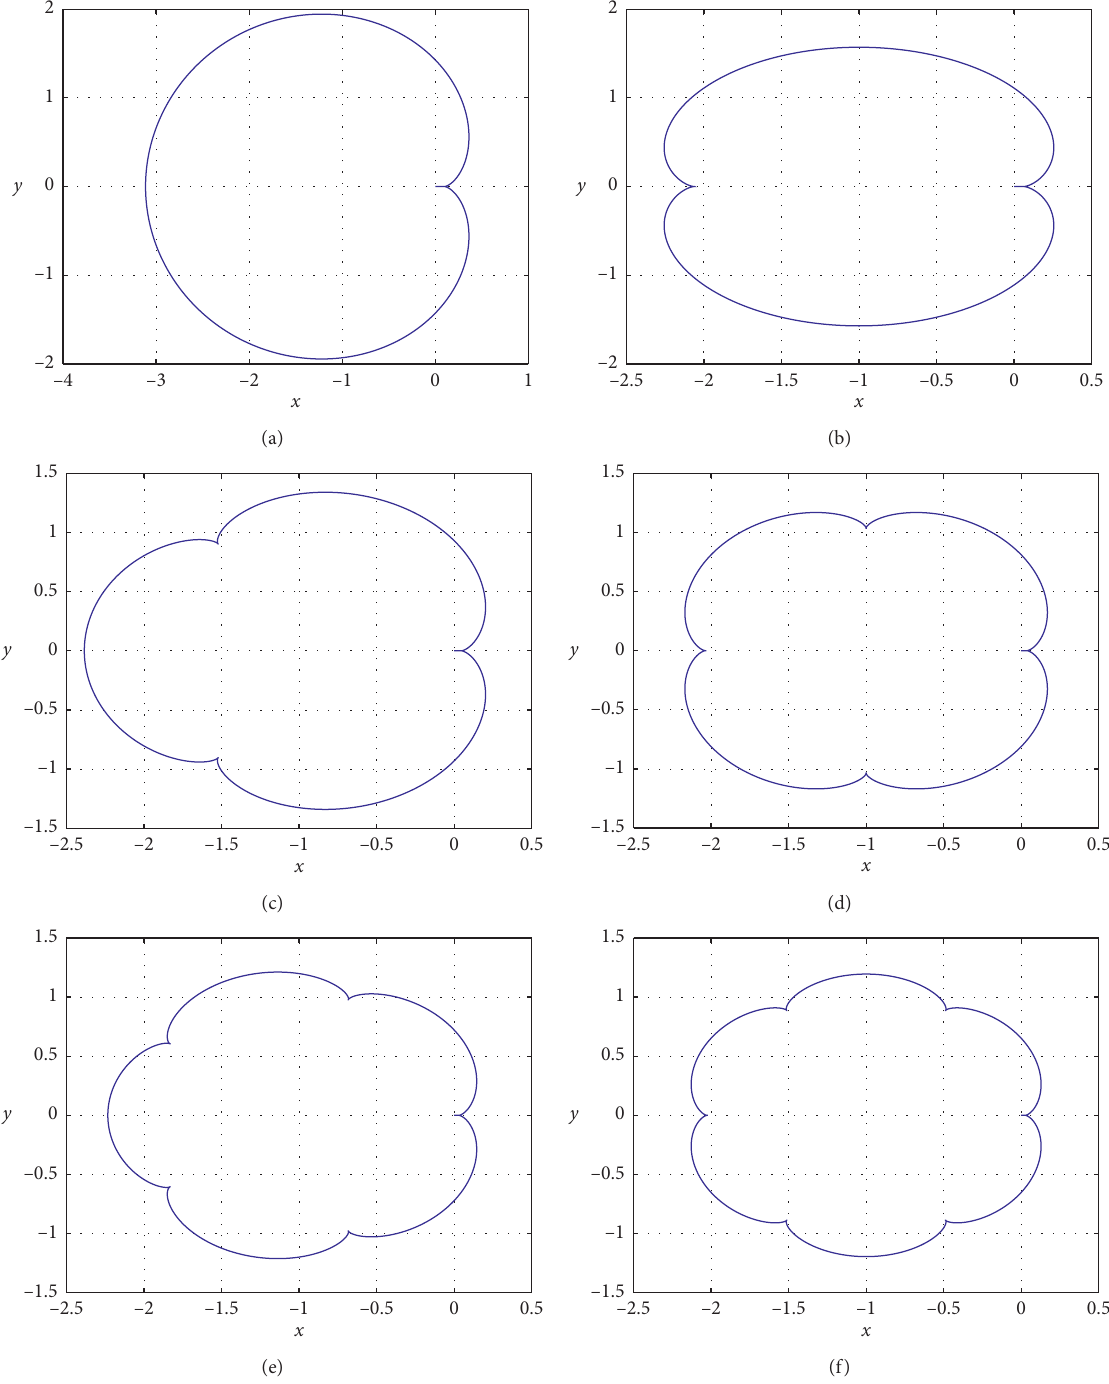
Figure 2: Periodic orbits when e � 0 . 1 ,f 0 � π /6, and velocity _ y 0 � 0 . 002. (a) Single-loop orbit, when x 0 � 0.097990643050. (b) Two-loop orbit, when x 0 � 0.060941913025. (c) Three-loop orbit, when x 0 � 0.0442639955. (d) Four-loop orbit, when x 0 � 0.03469385. (e) Five-loop orbit, when x 0 � 0.02847325. (f) Six-loop orbit, when x 0 �